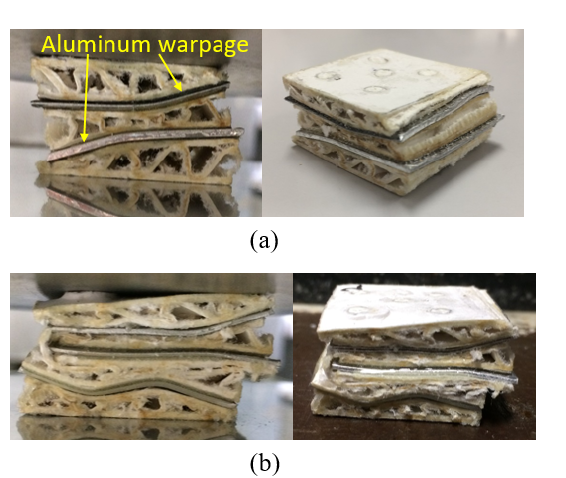
Figure 13: Images of multi-layered panel structures during and after compression testing: (a) CACAC panel structure; (b) CACACAC panel